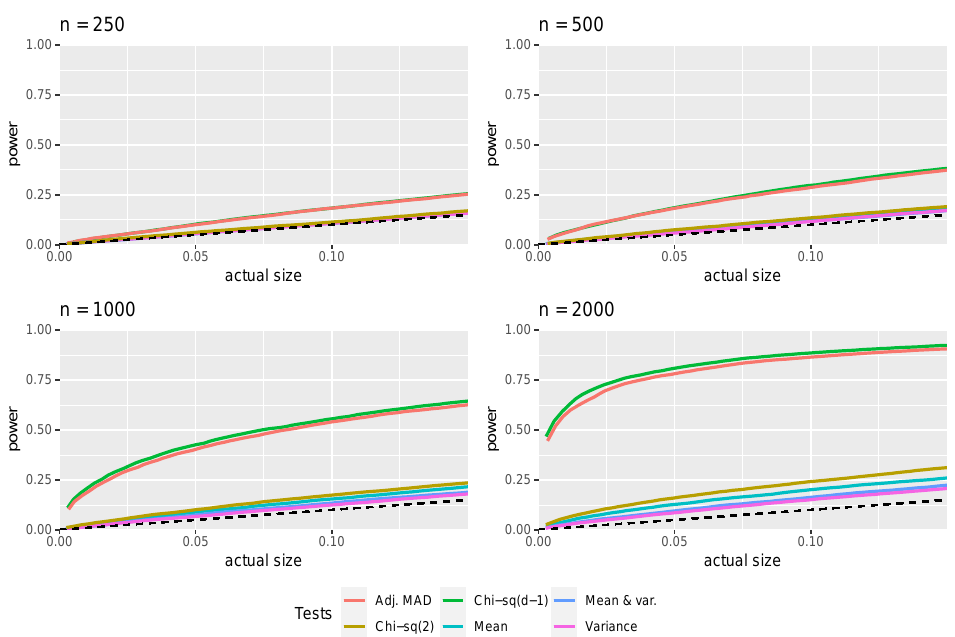
Figure 9. First two digits tests: size–power curves of the tests against the perturbed mixing alternative with λ = 0.75. Tests are as follows: “Adj. MAD”, adjusted MAD (10); “Chi-sq(2)”, χ 2 ( 2 ) test on mean and variance (4); “Chi-sq(d-1)”, χ 2 ( 89 ) test (9); “Mean”, normal test on the mean (1); “Mean & var.”, normal test on mean and variance (3); “Variance”, normal test on variance (2). The dashed line is power = actual size . The number of observations is indicated on top of each panel.